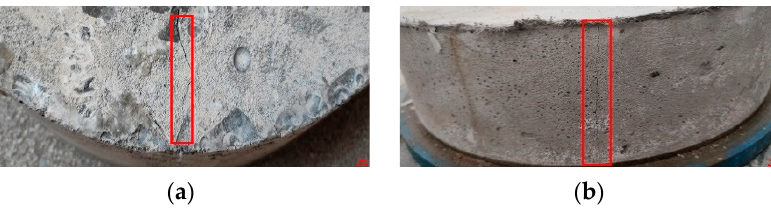
Figure 18. Crack status. ( a ) Concrete; ( b ) SSPP-ECC.